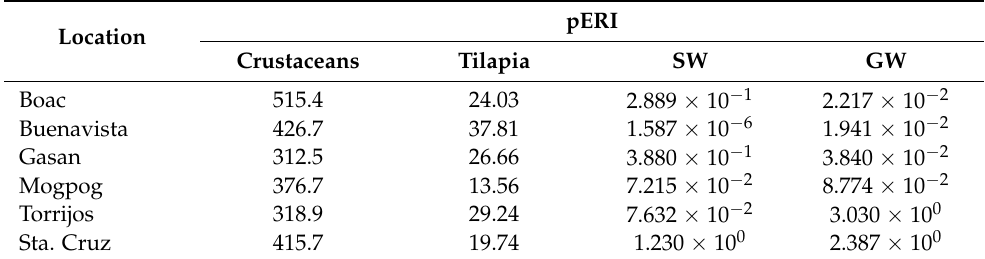
Figure 5. The spatial distribution of pERI at municipal level by the elevated metals concentration in ( a ) surface water, ( b ) groundwater, ( c ) crustaceans, and ( d ) tilapia. Table 8. The potential ecological risk index (p ERI ) in aquatic resources from